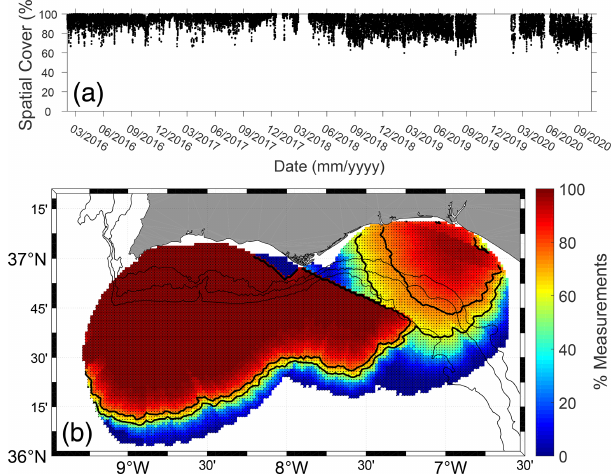
Figure 3. (a) Temporal distribution of the spatial coverage area con- sidering grid nodes having at least 60% of records. (b) Percentage of data at each grid node with indication of the 60% and 75% iso- contours (thick black lines). The isobaths of 100, 200 and 500m are represented as thin black